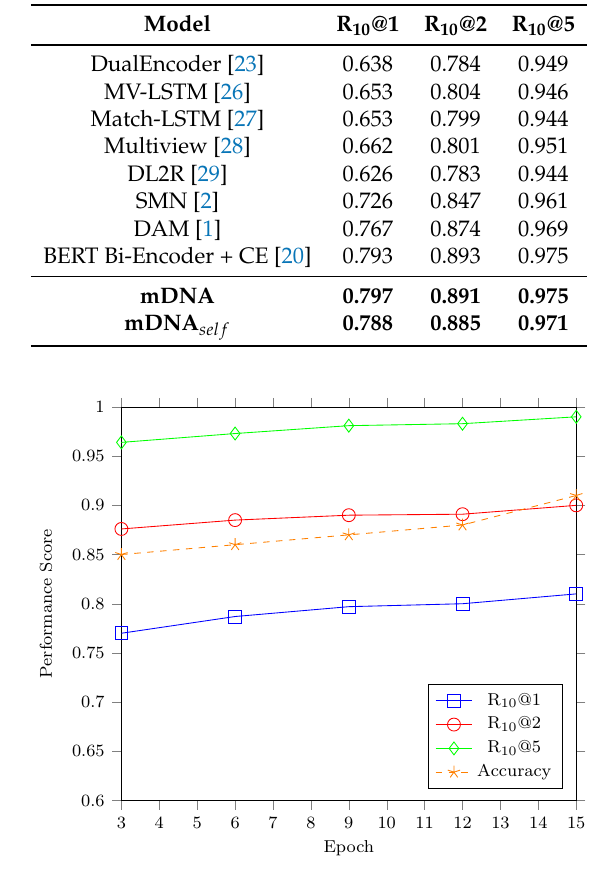
Figure 4. Plot showing increase in average accuracy (denoted as accuracy) scores and performance evaluation scores as the number of training epoch increases. The accuracy is averaged by R 10 @1, R 10 @2, and R 10 @5 at corresponding